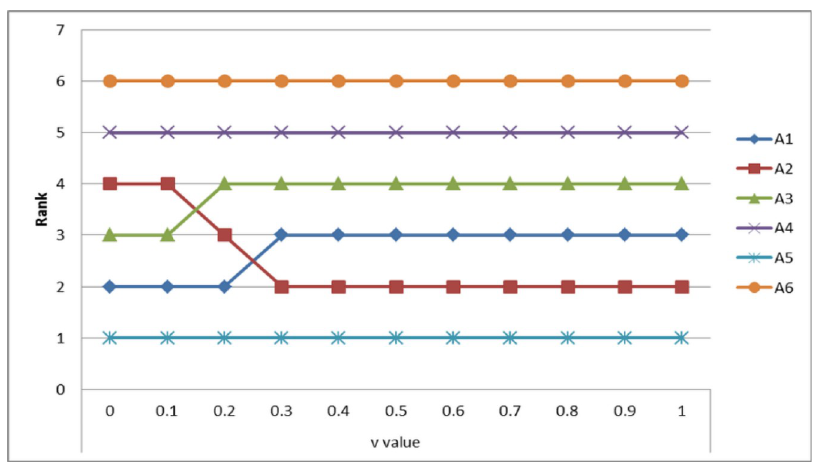
Fig 6. Sensitivity analysis for influence levels of the v value in VIKOR